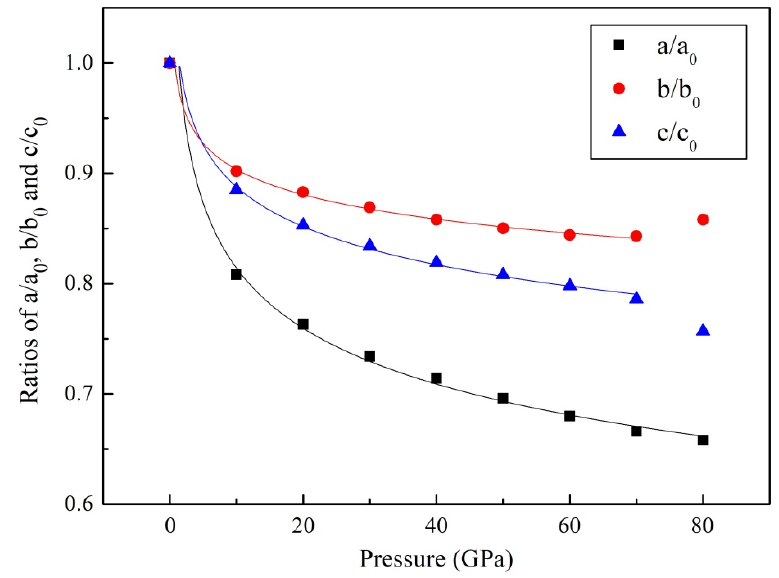
Figure 2. The lattice constant changes of DNTF under different pressure. The power equation is obtained by curve fitting of the existing data, according to which the influence of pressure on the lattice constant of DNTF can be fully understood. It is noteworthy that the crystal structure changes and the lattice constants (b and c) change abnormally when the pressure is 80 GPa. Therefore, when fitting b/b 0 and c/c 0 curves,